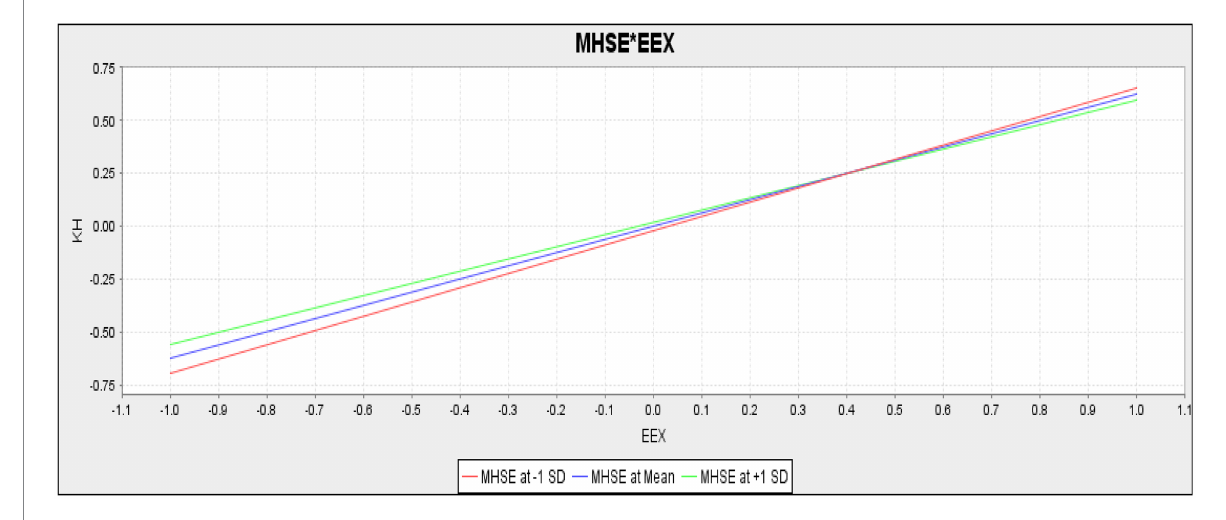
FIGURE 3 Slope for mental health self-efficacy (MHSE) and emotional exhaustion (EEX;